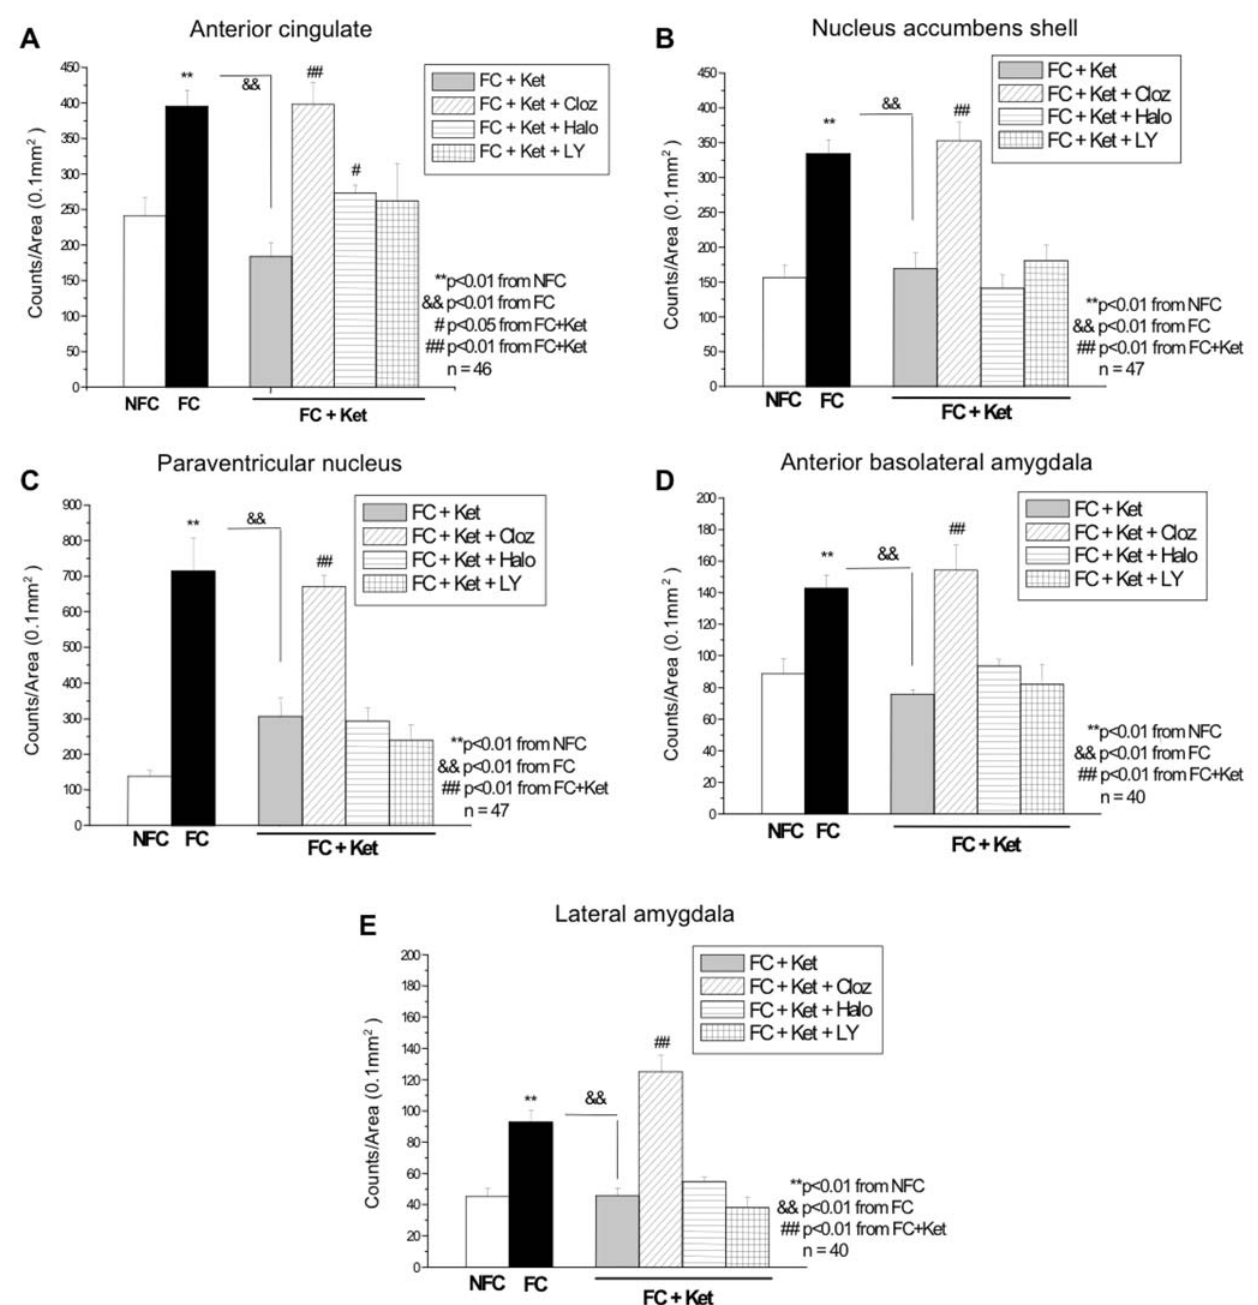
Figure 4. cFos expression. Fear conditioning (FC) increased cFos expression as compared to the NFC group in the anterior cingulate (p=0.003; A), nucleus accumbens shell (p , 0.0001; B), and paraventricular nucleus (p , 0.0001; C), anterior basolateral amygdala (p=0.002; D) and lateral amygdala (p , 0.0001; E). Ketamine blocked the effect of fear conditioning (FC vs. FC + Ket) in the anterior cingulate (p , 0.0001; A), nucleus accumbens shell (p=0.002; B), paraventricular nucleus (p , 0.0001; C), anterior basolateral amygdala (p=0.001) and lateral amygdala (p=0.004). As hypothesized, clozapine was able to counteract the blockade of ketamine on fear conditioning (FC + Ket vs. FC + Ket + Cloz) in the anterior cingulate (p , 0.0001), nucleus accumbens shell (p=0.001), paraventricular nucleus (p=0.001), anterior basolateral amygdala (p , 0.0001) and lateral amygdala (p , 0.0001). A slight restoration by haloperidol was noted in the anterior cingulate (p=0.042). Cloz, clozapine; FC, fear conditioning; Halo, haloperidol; Ket, Ketamine; LY, LY 379278; NFC, no fear conditioning. (p , 0.0001; Fig. 4B), and PVN (p , 0.0001; Fig. 4C). More Ketamine led to the hypothesized blocking of cFos expression due to fear conditioning (FC vs. FC + Ket) in all the brain areas importantly, increases due to fear conditioning were noted in the anterior portion of the BLA (p =0.002; Fig. 4D) and lateral investigated, i.e. the ACC (p , 0.0001), Nacc shell (p=0.002), PVN amygdala (p , 0.0001; Fig. 4E). (p , 0.0001), anterior BLA (p=0.001) and lateral amygdala